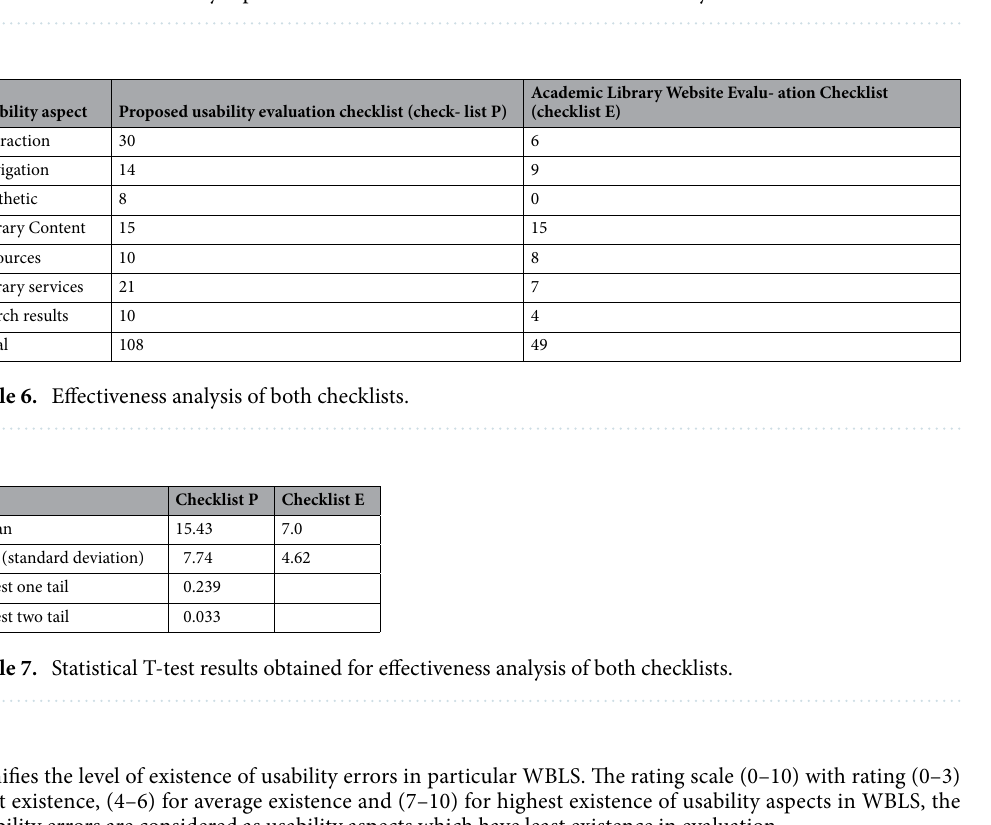
Table 5. Common usability aspects between both checklists for effectiveness analysis.